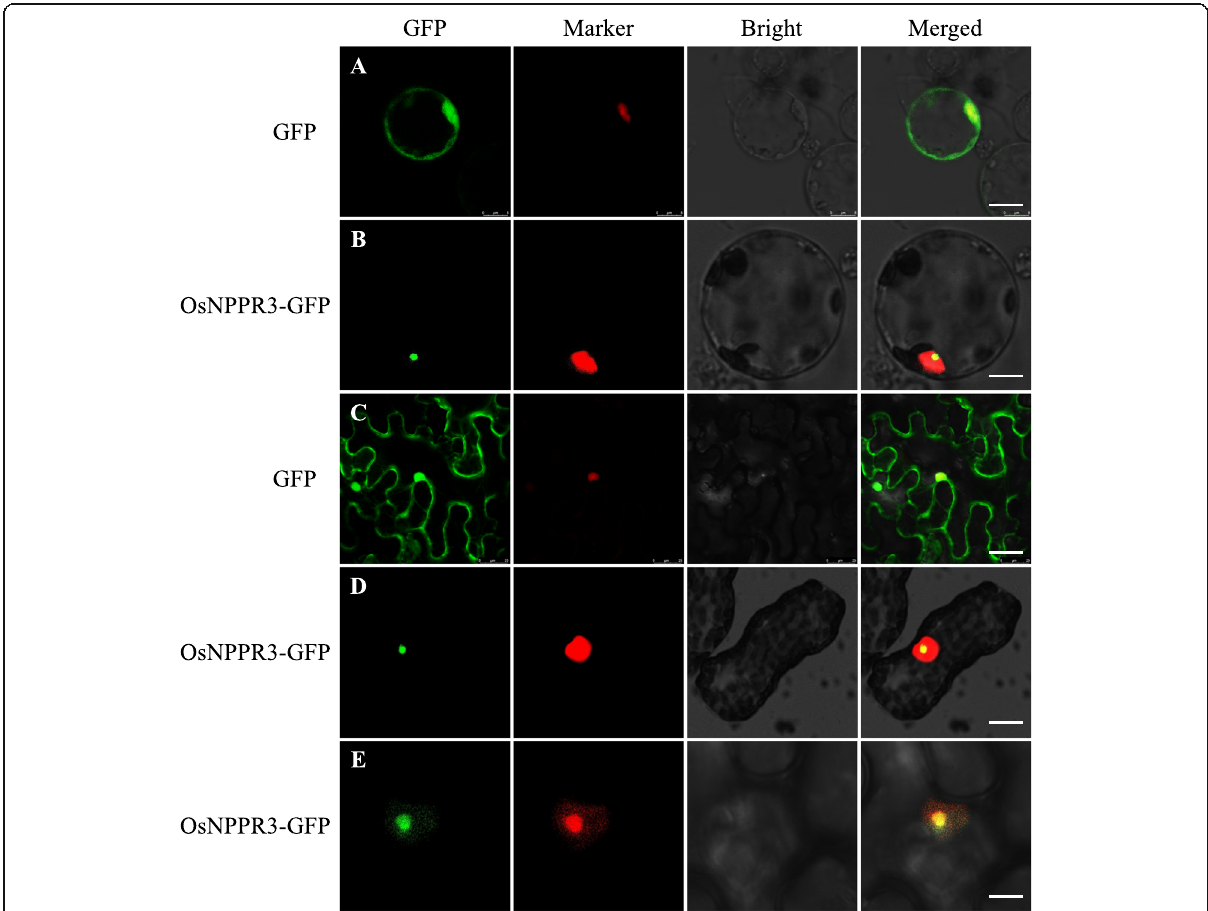
Fig. 6 Subcellular localization of OsNPPR3. a - e Transient expression of 35S: OsNPPR3-GFP fusion protein located in the nucleolus of rice protoplasts ( a , b ) and Nicotiana tabacum protoplasts ( c - e ). Nucleus marker was used as a nucleus indicator ( a - d ). Nucleolus marker was used as a nucleolus indicator ( e ). RPBF (Rice Prolamin Box Binding Factor) and RPL23aB (r-Protein family member) were employed as nucleus-targeted and nucleolus-targeted marker, respectively. Scale bars: 1.6 μ m in ( a ), 5 μ m in ( b , c ), 10 μ m in ( d , e